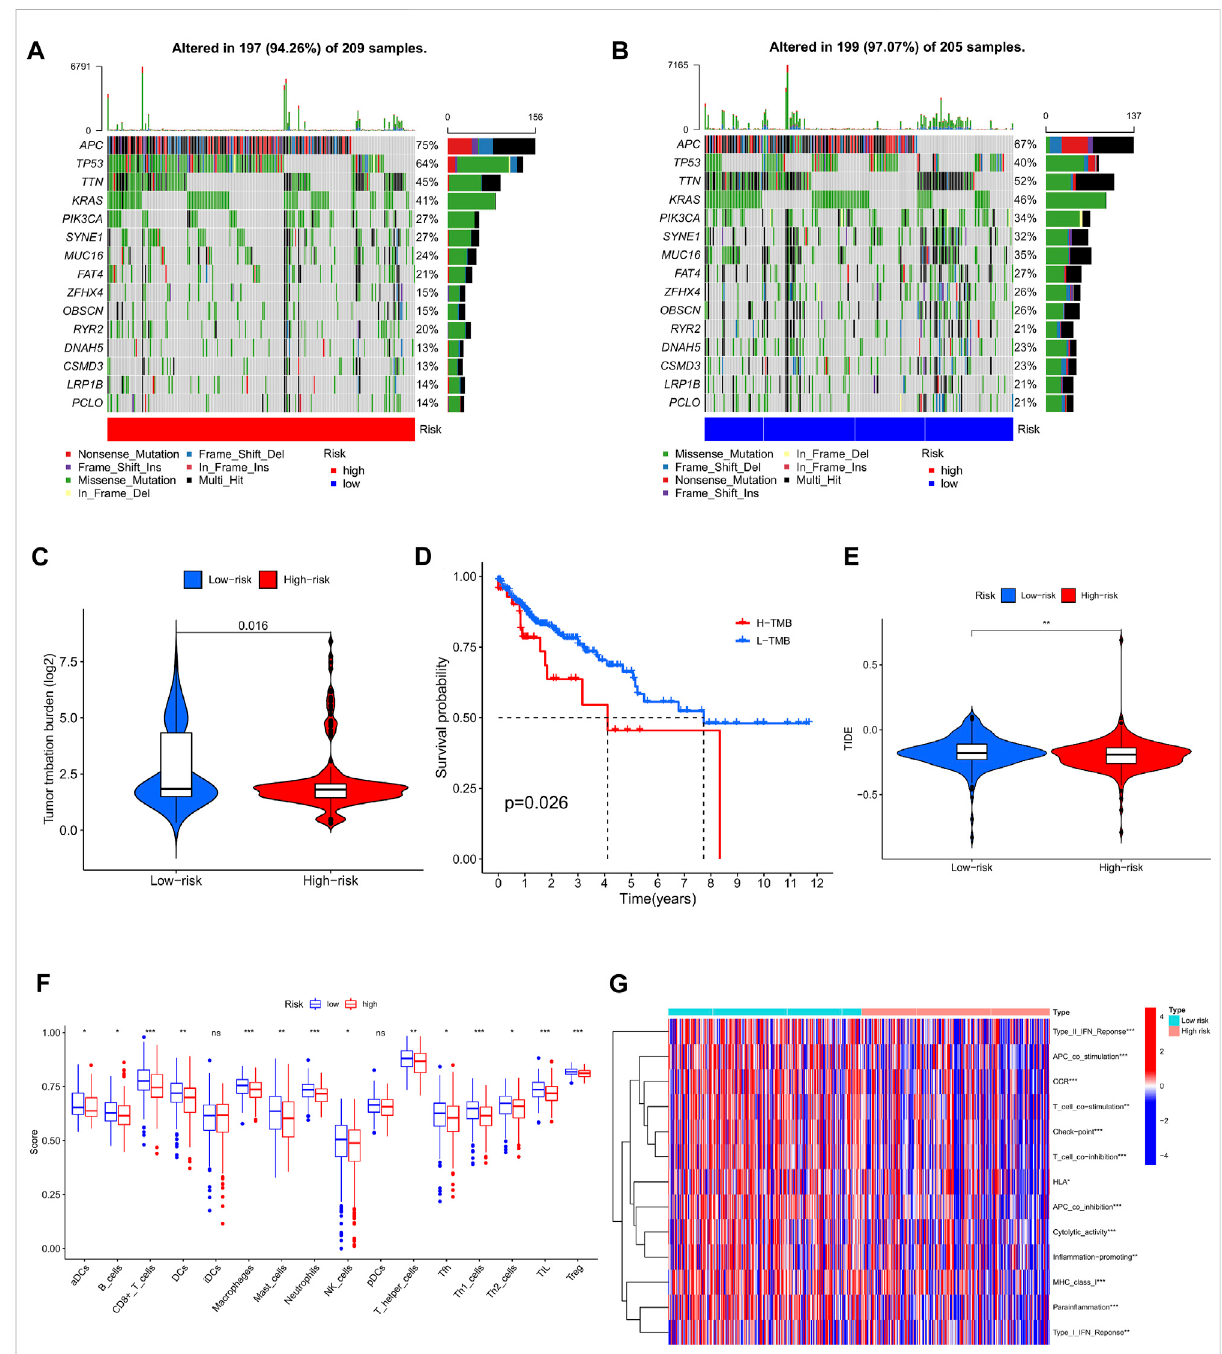
FIGURE 9 Analysis of tumor mutation burden and immune function in high and low risk groups. (A) Waterfall plot of mutant genes in the high-risk group. (B) Waterfallplotofmutantgenesinthelow-risk group. (C) Violin plotofTMBcontrastinhighandlowriskgroups. (D) Kaplan-Meiercurvesof H-TMB and L-TMB. (E) TIDE violin plot between high and low risk groups (F) Boxplot comparison of immune in fi ltrating cells between high and low risk group. (G) Comparison of immune-related functions between high and low risk